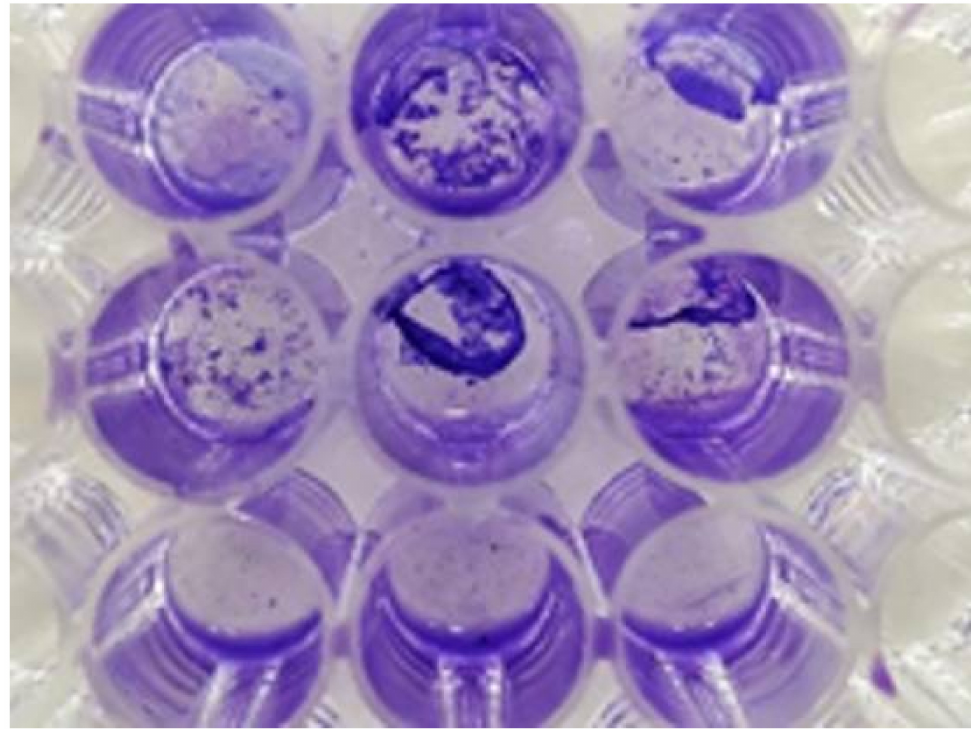
Figure 10. Crystal violet-stained biofilms in CS, CS-ZnHNTs, and CS-ZnHNTs-GS wells (top–bottom, respectively).